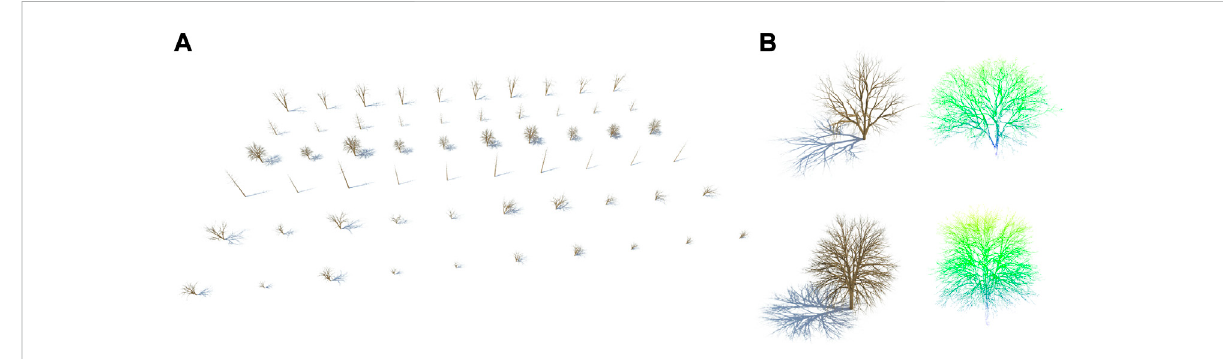
FIGURE 2 Synthetic dataset of 3D trees. (A) Procedural trees generated from Sapling Tree Gen. (B) Point clouds obtained from virtual aerial LiDAR scanning.